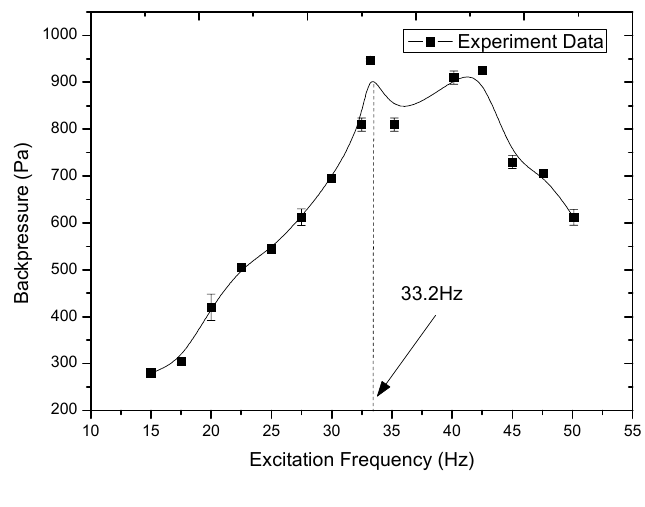
Figure 8. Backpressure varying with excitation